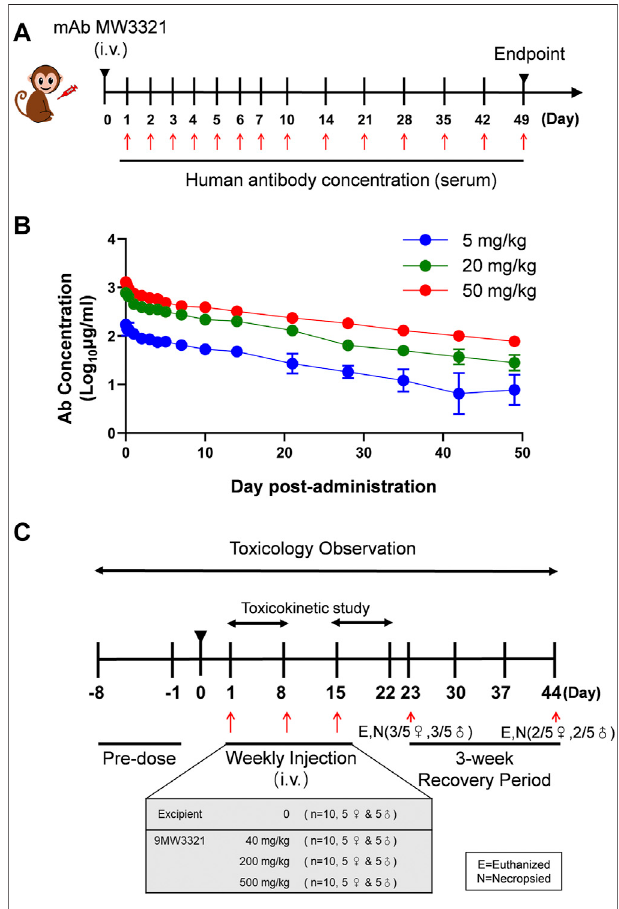
FIGURE4| Pharmacokineticpro fi leofMW3321. (A) Schematicdiagram of pharmacokinetic studies of MW3321. A single dose of MW3321 (5 mg/kg, 20 mg/kg, and 50 mg/kg) was administered to cynomolgus monkeys (3/sex/ group) by intravenous injection. Serum samples were collected at different time points and measured after that (B) Mean serum MW3321 concentrationincynomolgusmonkeys.Dataarepresentedasmean±SD, n = 6. (C) Schematic diagram of toxicology study. Different dose of MW3321 was administered to cynomolgus monkeys (5/sex/group) by intravenous infusions once a week for 3 weeks, with a 3-week recovery period. The indicated numberofanimalsineachgroupwereeuthanizedandnecropsiedonD23and D44. Toxicokinetic studies started from pre-dose (0 h) to 168 h post-dose on D1 and D15. Other evaluations and parameters were studied during the pre- dose and post-dose